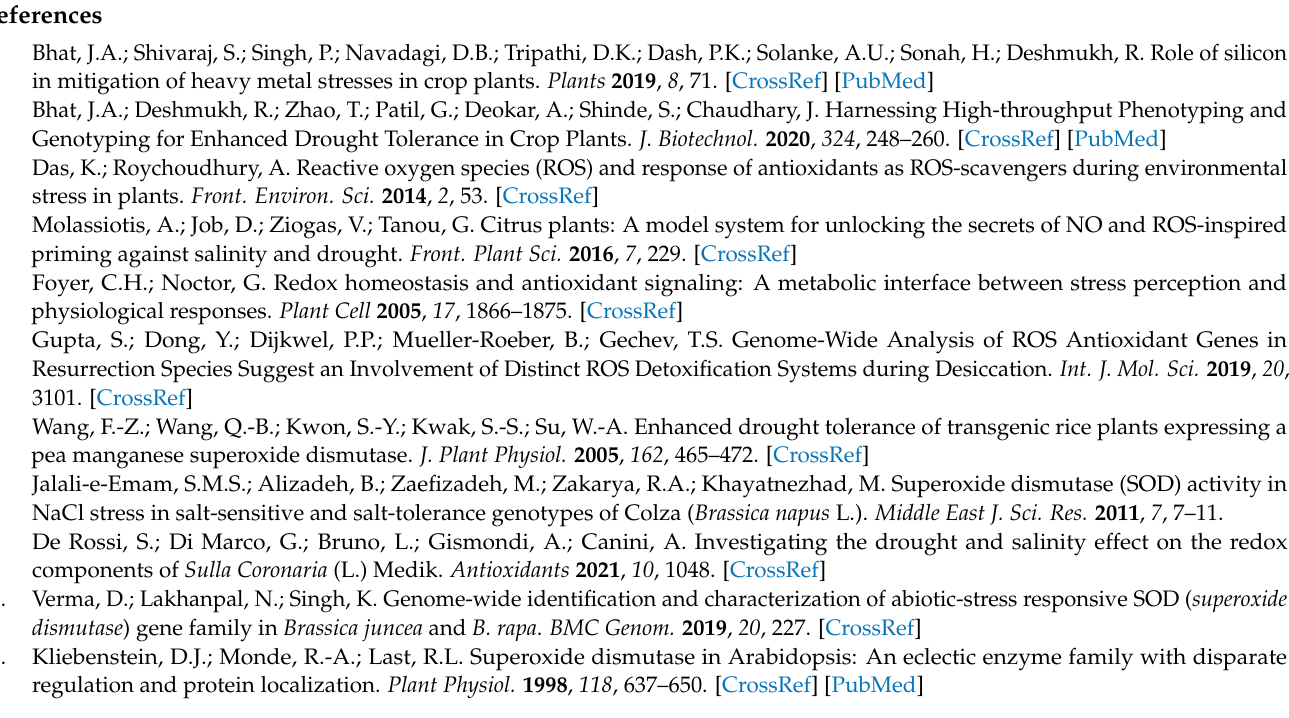
Table S4: Similarities of the the SOD and GPX genes of G. max and G. soja ; and similarities of the SOD and GPX genes of G. max and G. soja with model legume M. truncatula ; Table S5: Details of SOD and GPX genes in studied